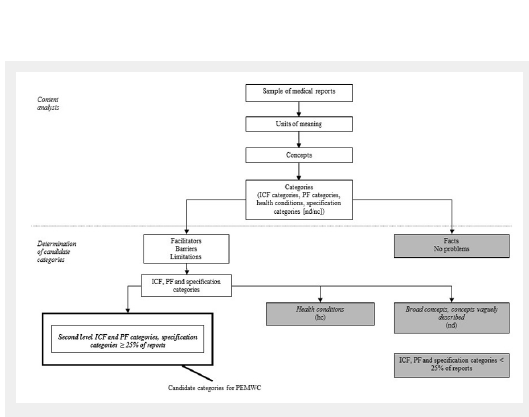
Overview of the selection process for the candidate categories. PF = personal factor; hc = health conditions; nd = not definable with the ICF; nc = not covered by ICF; boxes shaded in grey refer to concepts that were excluded in the selection process for the candidate categories.